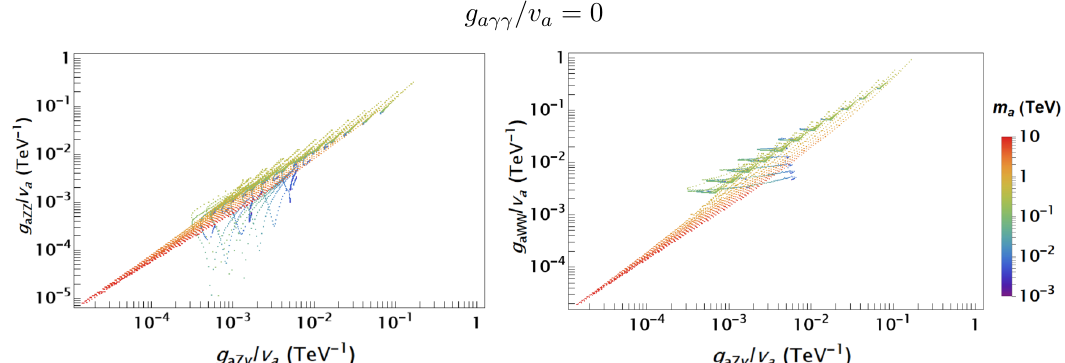
Figure 2 . Prediction for the ALP-EW gauge boson coupling projected in the planes ( g aZZ , g aZγ ) and ( g aWW , g aZγ ) (from left to right) and their dependence on the ALP mass m a in the photophobic scenario for v a = 1 TeV. In this plot we scanned logarithmically all three parameters, m a , χ u and χ d , with both χ u and χ d varying between 0 . 1 and 10 , and m a ranging between 1 GeV and 10 TeV. Note that direct bounds on the ALP-fermion couplings have not been enforced, and may rule out part of these